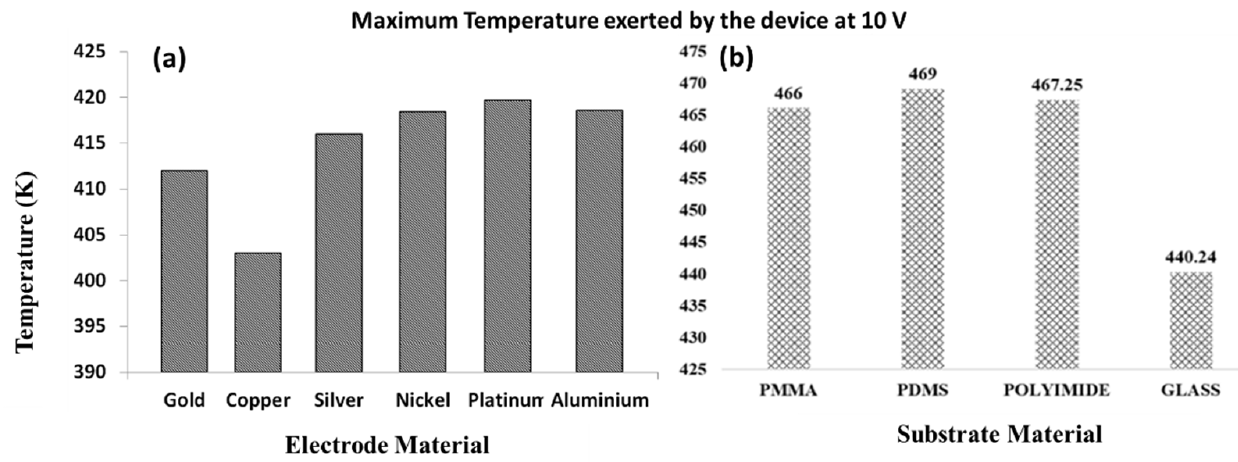
Figure 3. Simulation predicts that, choice of different electrode materials and substrate materials causes strong thermal distributions eventually affecting reliability and performance of the sorting system. ( a ) Simulation graph reveals that copper electrode has least thermal distributions (less joule heating) even at the applied potential of 10 V, however increasing the potential erodes the channel quickly compared to gold and platinum. ( b ) At the applied potential of 10 V, only glass has very least thermal distribution and joule heating effects for effective performance of the device.